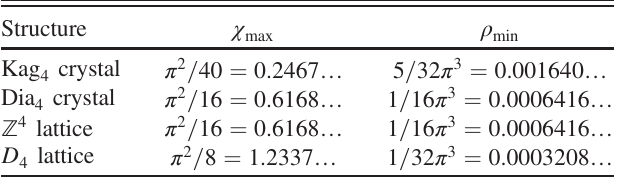
TABLE IV. Maximum values of χ and corresponding minimum values of ρ for certain periodic stealthy ground states in R 4 with K ¼ 1 . The configuration with the largest possible value of χ (smallest possible value of ρ ) corresponds to the four- max min dimensional checkerboard lattice D 4 ≡ D (cid:3) 4 .